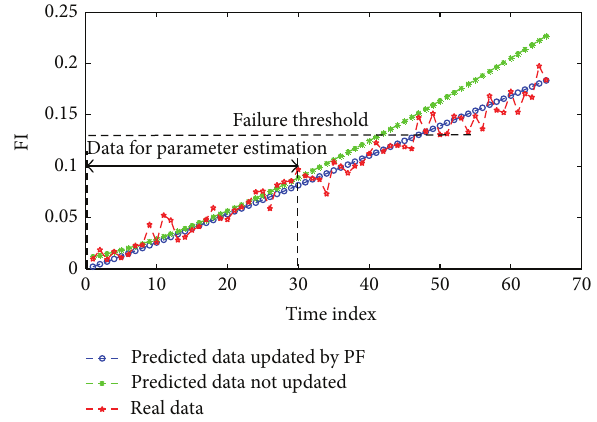
Figure 13: The result obtained when 30 practically tested data about time indexes are used to predict 20% of 𝑅3 deviation in a forward